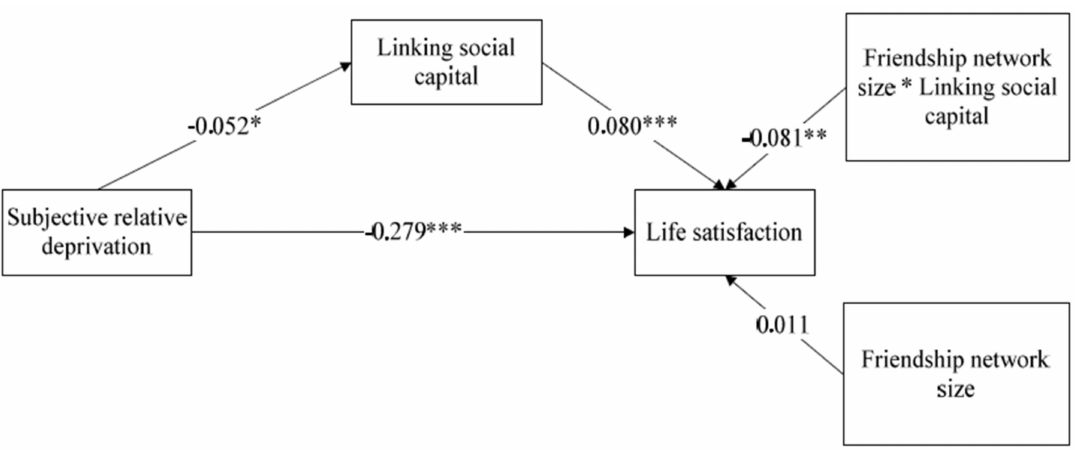
Figure 4. A path model of how subjective relative deprivation influences life satisfaction with friendship